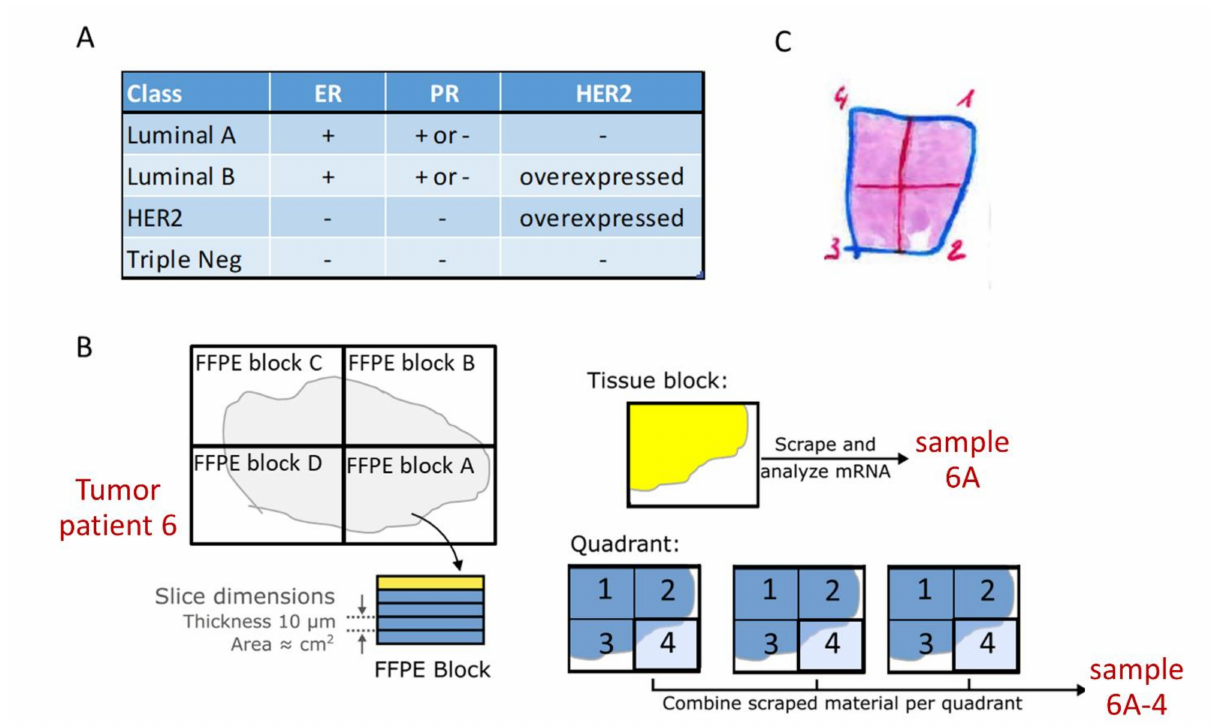
Figure 1. Analyzed primary breast cancer samples. ( A ) Pathology classification of analyzed primary breast cancers. Surro- gate classification of Luminal A and Luminal B subtypes based on the surrogate definitions from [26], using ER/PR/HER2 immunohistochemistry staining. ( B ) Tissue samples analyzed from surgically resected primary tumors were either a tissue block sample or a quadrant sample. Tissue block samples were obtained by scraping one or more adjacent slides (depending on the amount of cancer tissue per slide) from each available FFPE tissue block. The tumor tissue area was annotated by a pathologist and tumor-containing areas were scraped from the slide(s) for RNA isolation. Quadrant samples were obtained from one randomly selected FFPE tissue block per patient. Sequential tissue slides were divided into 4 quarts, tumor areas annotated and tissue from the quarts scraped from the slides for RNA isolation. Care was taken to scrape only cancer tissue. To obtain similar amounts of tumor tissue, multiple adjacent slides were scraped until the same area of scraped tumor had been collected. ( C ) Typical example of a tissue block sample, showing how quadrant sample areas were divided. More examples are given in Supplementary Figure